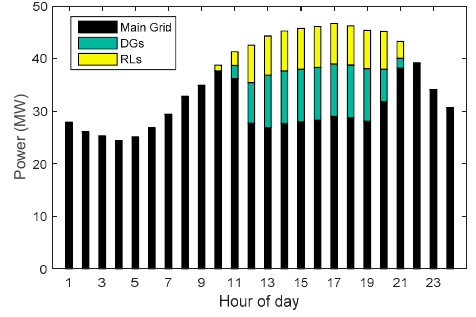
Figure 8. Energy resources scheduling result for Case 4.